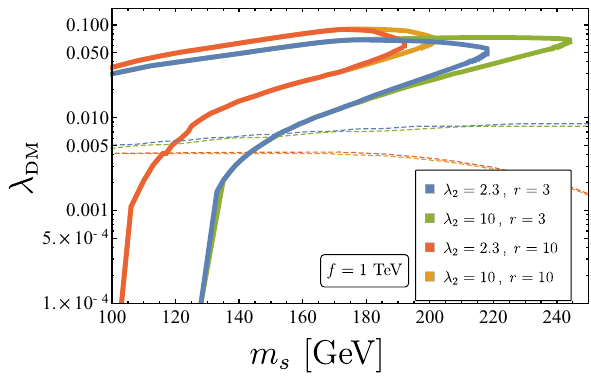
Fig. 7 The effects of changing r and λ 2 on the relic abundance curves, shown as solid curves. The dashed curves represent the XENON1T [59] bounds after 34.2 live days. Increasing r has similar effects to lowering f - the coefficients of the non-renormalizable terms increase and their effect is noticeable at lower DM masses. Increasing λ 2 reduces the size of the coefficient of the dimension 5 contact term, therefore increasing √ m max s = x max